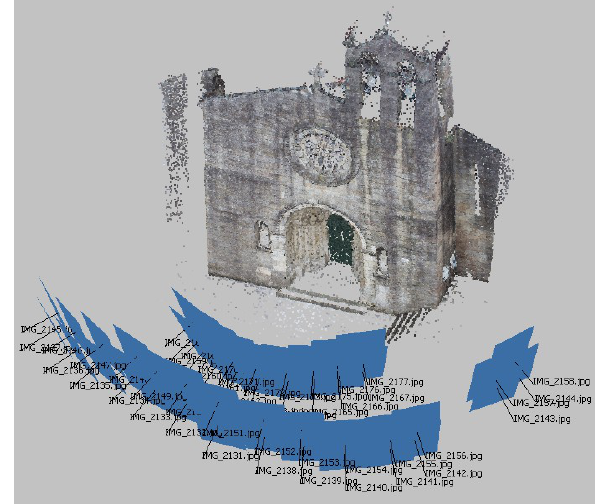
Figure 4. Merged sparse point cloud of the whole project with the two sets of tripod placements and all the images (28+18).